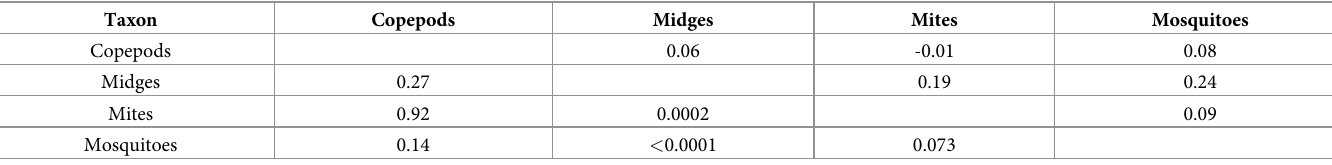
Table 2. Spearman rank correlation matrix relating abundances of four invertebrate taxa within pitchers.